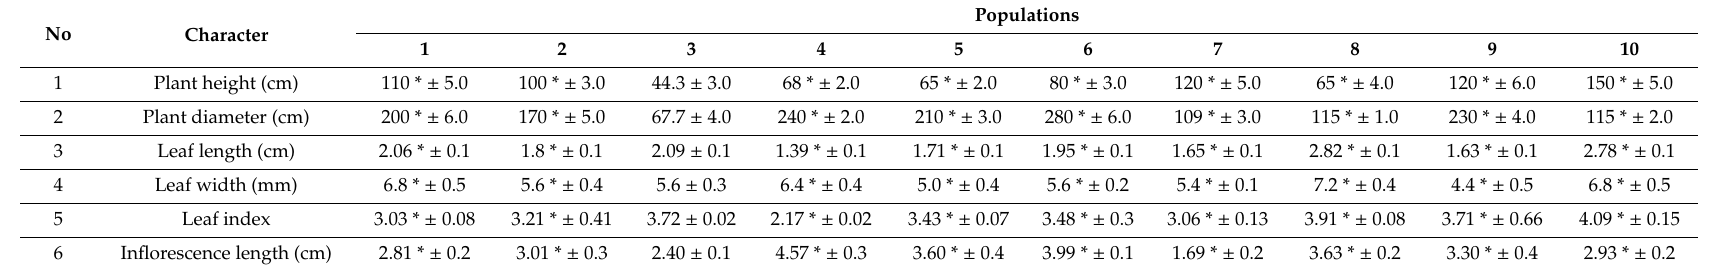
Table 2. The average value of the measurements for the quantitative traits ± SD for the examined populations of A. javanica